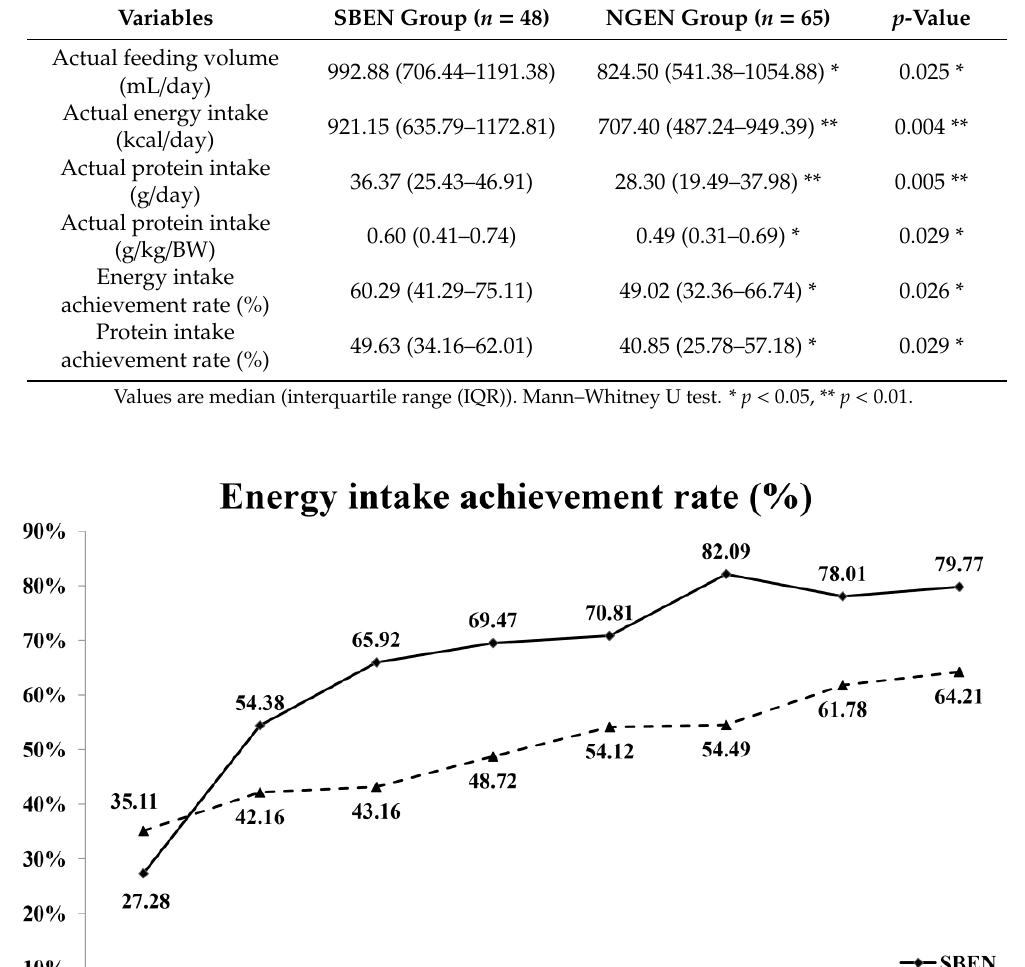
Table 2. Comparison of feeding efficiency between SBEN and NGEN groups on the third day after enrollment in malnourished, critically ill, ICU patients.